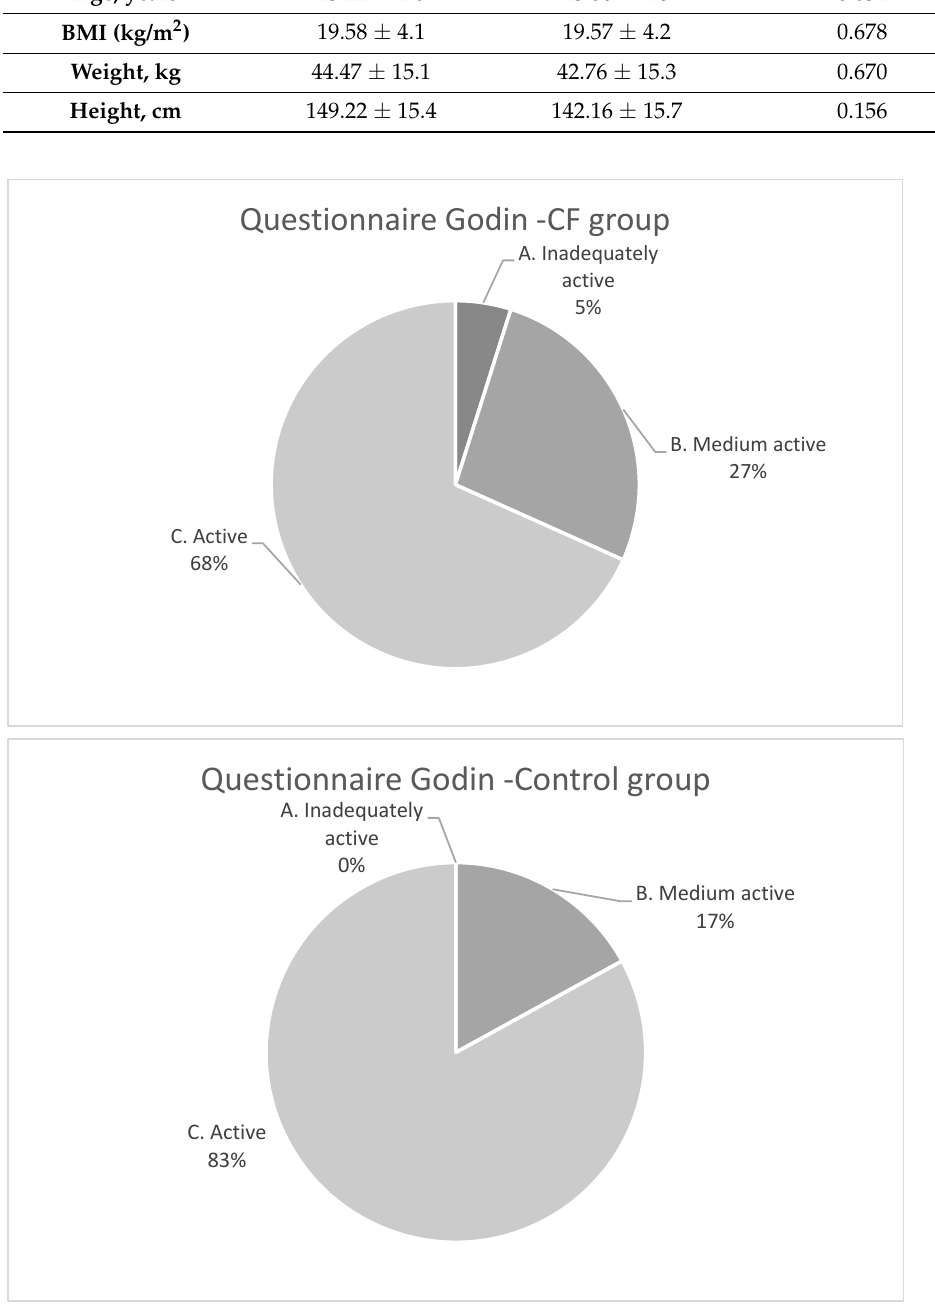
Figure 1. Physical activity (Godin Questionnaire) among pwCF and healthy controls.